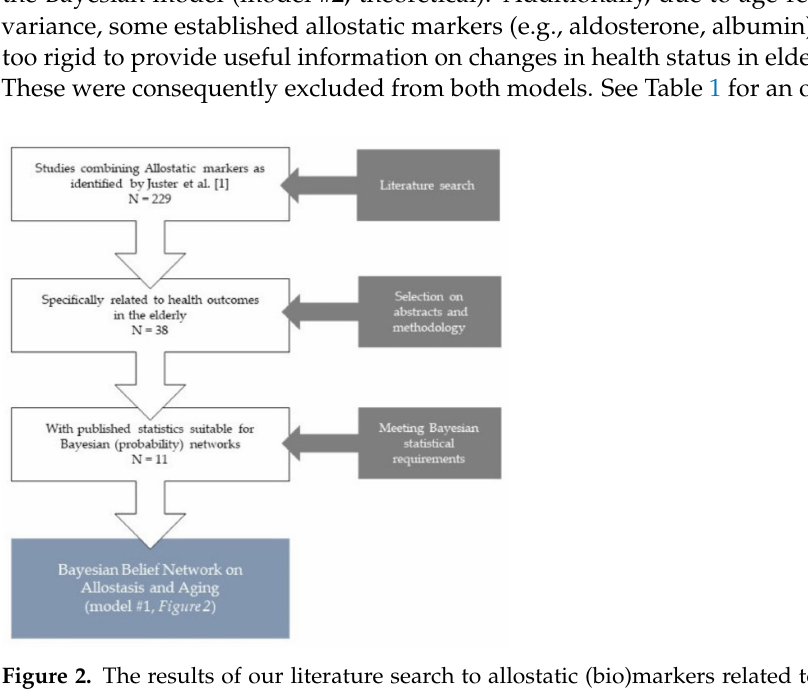
Figure 2. The results of our literature search to allostatic (bio)markers related to health status of well-defined disease states in the elderly (see Table